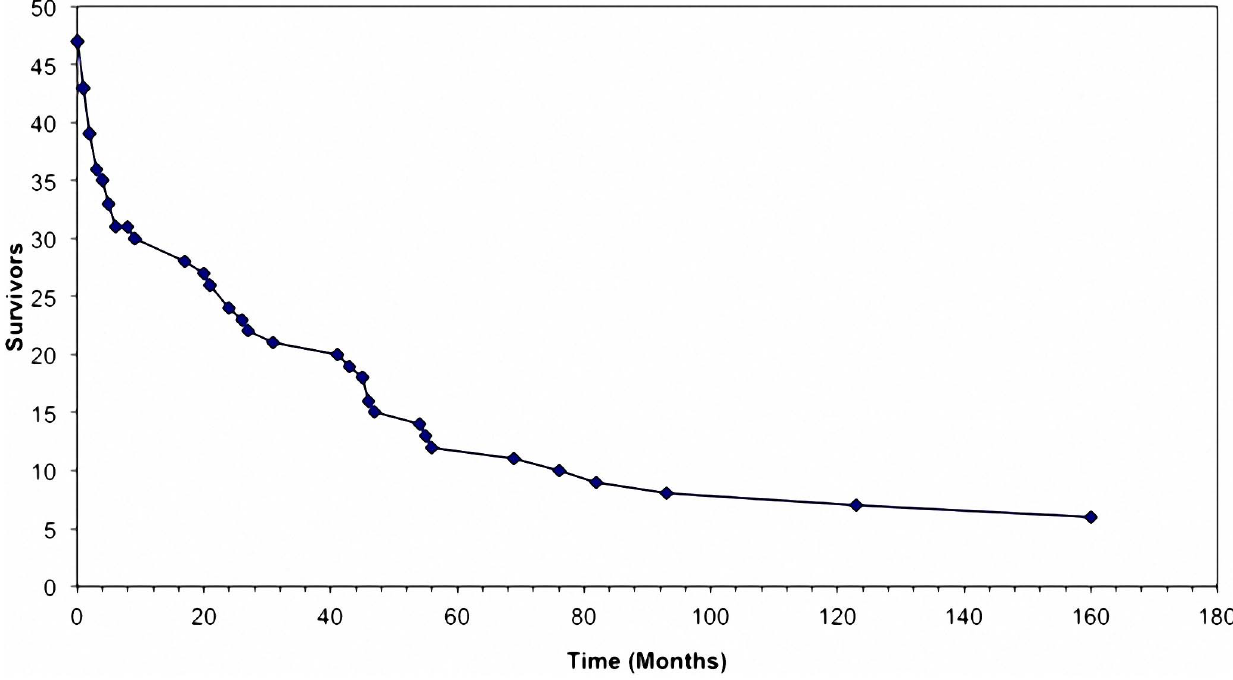
Figure 1. Kaplan Meier curve showing survival of patients who developed VTE with date of VTE as time origin. Thirty-five of 41 (85.3%) patients with VTE died, 20 (57.1%) within 1 year.